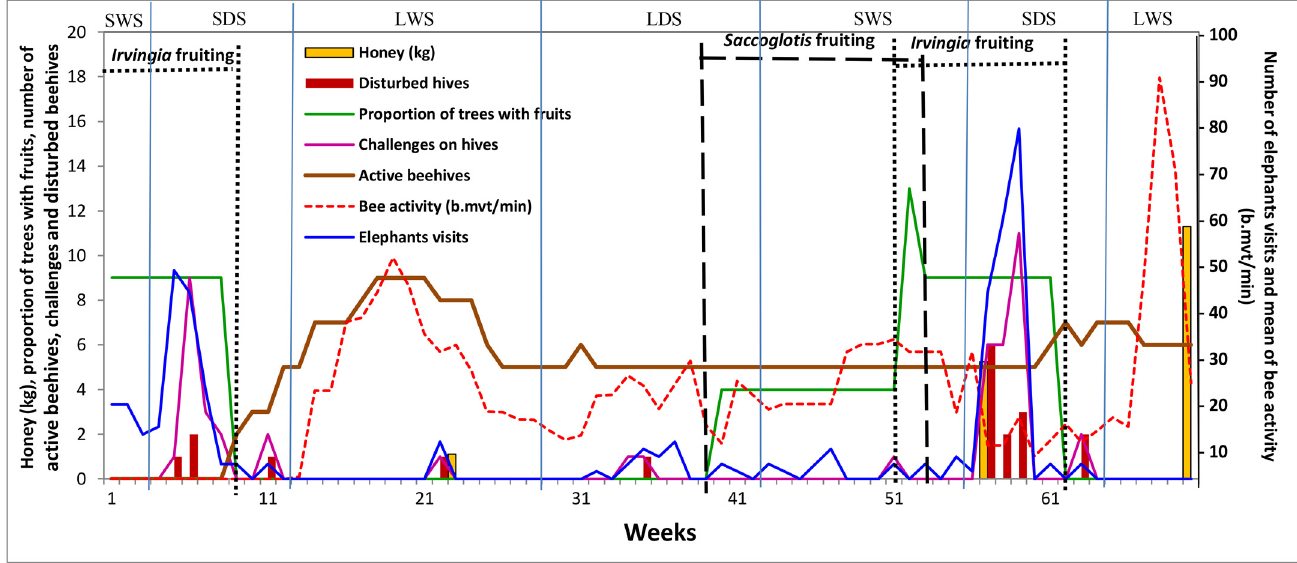
Fig 1. Summary of elephant behaviors and honey collected. SDS, short dry season; LDS, long dry season; SWS, short wet season; LWS, long wet season. Elephant behaviors and measured factors including number of elephants visits, number of challenges on beehives, number of disturbances on hives, number of active beehives, mean of bee activity expressed in bee movement per minute (b.mvt/min) varied according seasons.